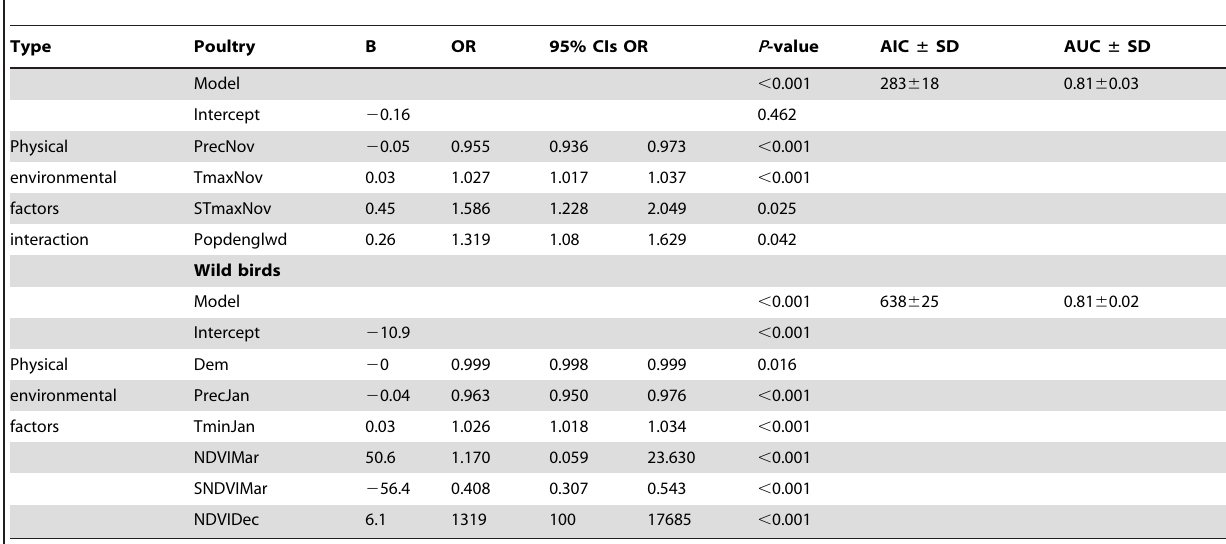
Table 3. Comparison of significant environmental factors correlated to HPAI H5N1 outbreaks in poultry (this study) and wild birds (adapted from [4]) in Europe, as maintained in the final multiple logistic regression